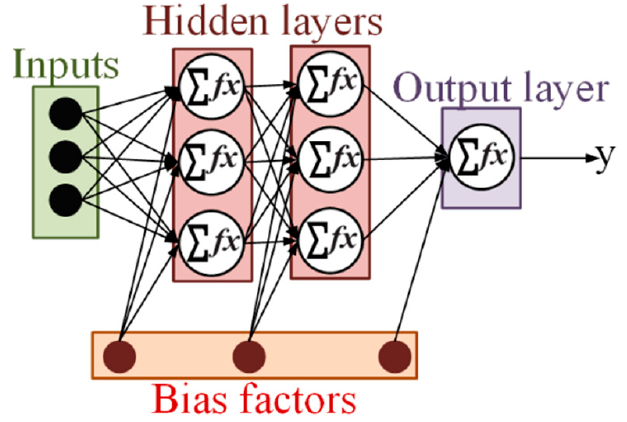
Figure 4. General structure for an ANN-based model.